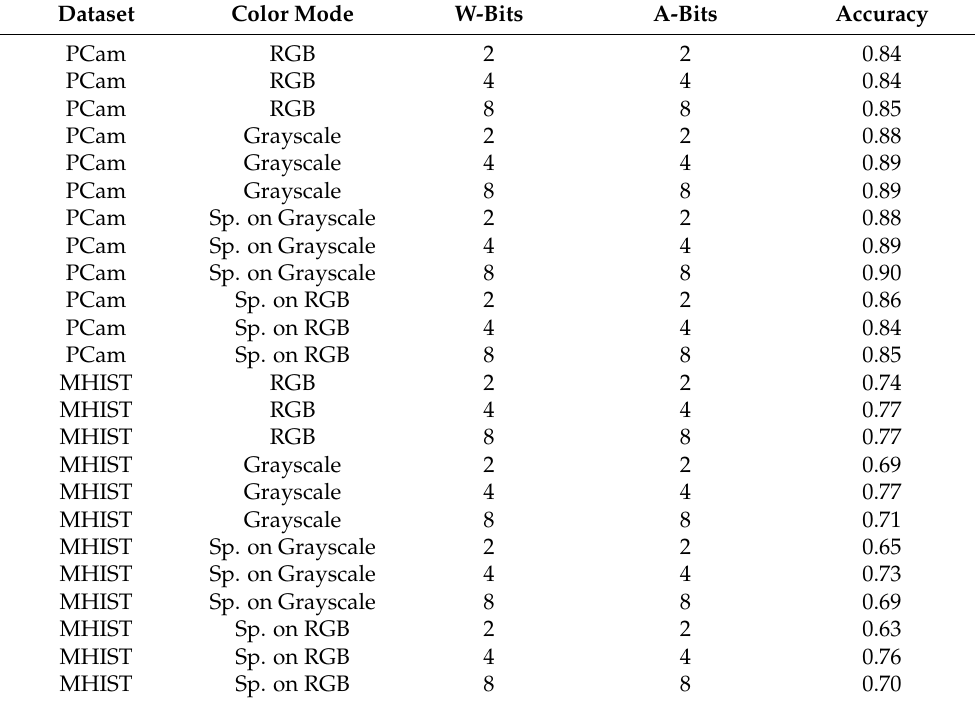
Table 3. Inference accuracy results of training ResNet20 with lower bit-width on weight (W-bits) and activation parameters (A-bits). The result is reported for each dataset with respect to each color